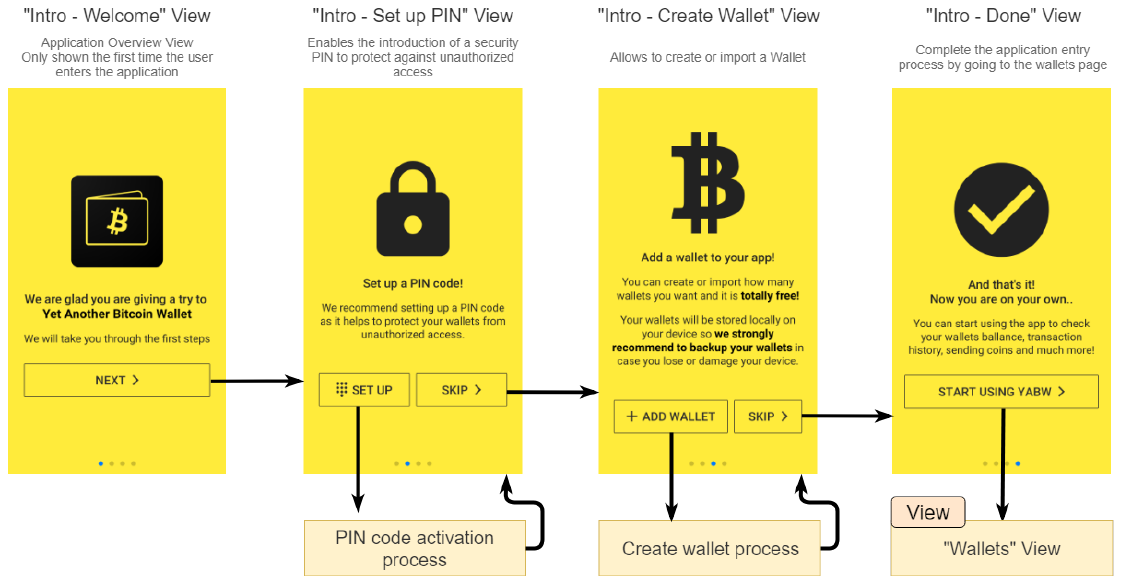
Figure 4. Navigability diagram of the application introduction views.